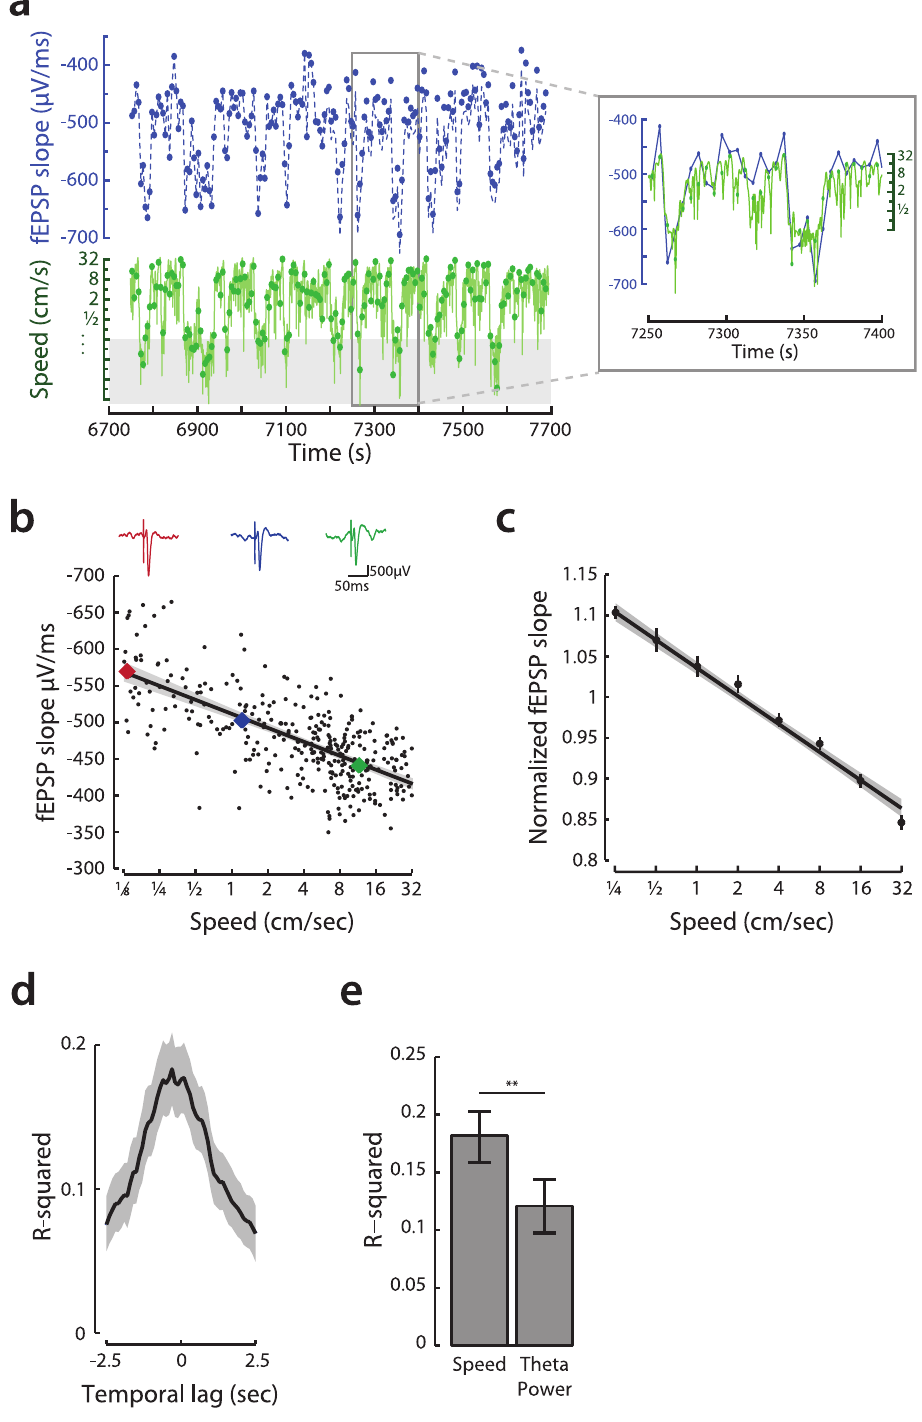
Figure 7. Rapid modulation of the Schaffer collateral pathway as a function of movement speed. a, In this study we combined measurements of fPSPs recorded in 4 animals and a total of 31 behavioral epochs. a, There is considerable variation in measured fPSP slopes as the rat behaves. In an example epoch (same animal, and one of the two epochs aggregated in Figure 5), the inverse relationship between the slopes of evoked fPSPs (blue dots) and movement speed (green with measurement times denoted with dots) can be observed. Note that the speed axis is logarithmic for similarity with our analyses and that the larger fPSP slopes are at the bottom of the axis. Furthermore, note the times when speeds went below 1/8 cm/s (marked in gray) are excluded from analyses. b, Modulation of EPSPs evoked in area CA1 by stimulation of the SC pathway as a function of speed. Colored points represent the measured slopes of the individual fPSP example shown at top. The regression of fPSP slope against log(speed) is shown with a 95% confidence interval estimated by bootstrap. c, The modulation of the SC pathway by speed is seen in fPSP measurements normalized and pooled across animals/recording sessions. Normalized measurements are displayed both as binned averages (binned